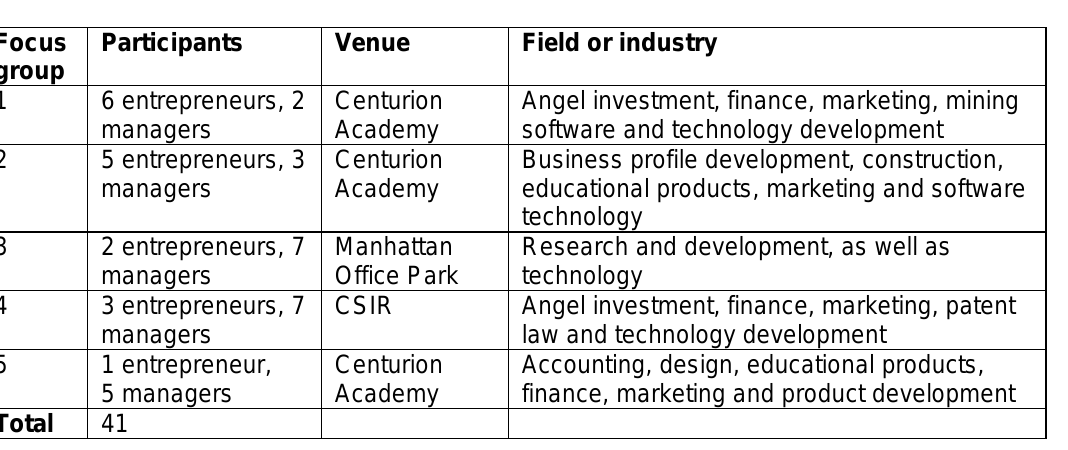
Table 1: Overview of